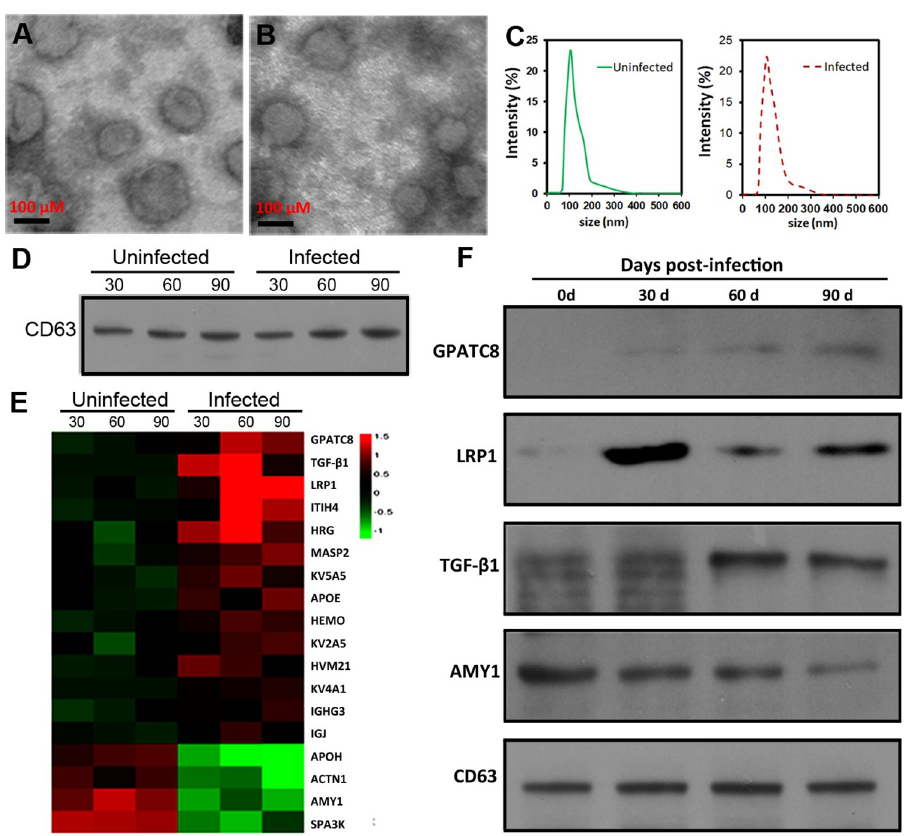
Fig 1. The dynamic changes of mouse proteins in serum-derived exosomes in response to E . multilocularis infection. (A) and (B) Transmission electron microscopy of the enriched extracellular vesicles (EVs) isolated from the sera of E . multilocularis -infected (A) and uninfected mice (B). (C) The diameter distribution of the purified EVs. (D) Western blotting analysis of mammalian EV-marker CD63 in the purified EVs. (E) Heatmap of differentially abundance proteins between the serum exosomes from E . multilocularis -infected and uninfected mice. (F) Western blotting analysis the abundance of TGF- β 1, GPATC8, LRP1, and AMY1 during E . multilocularis infection.